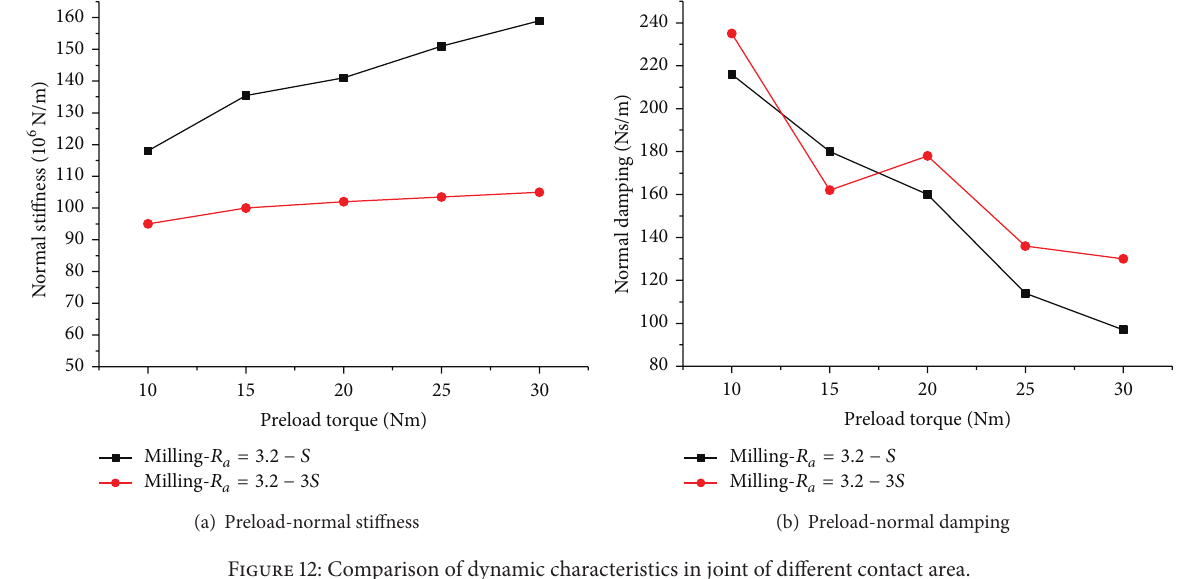
Figure 12: Comparison of dynamic characteristics in joint of different contact area.